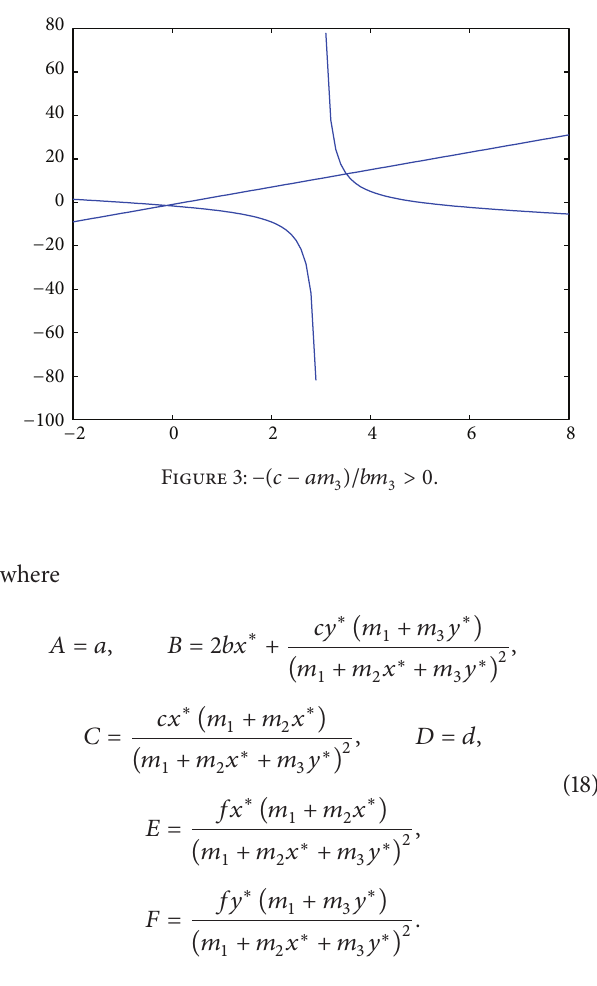
Figure 2: −(𝑐 − 𝑎𝑚 3 )/𝑏𝑚 3 < −𝑚 1 /𝑚 2 < 0 .